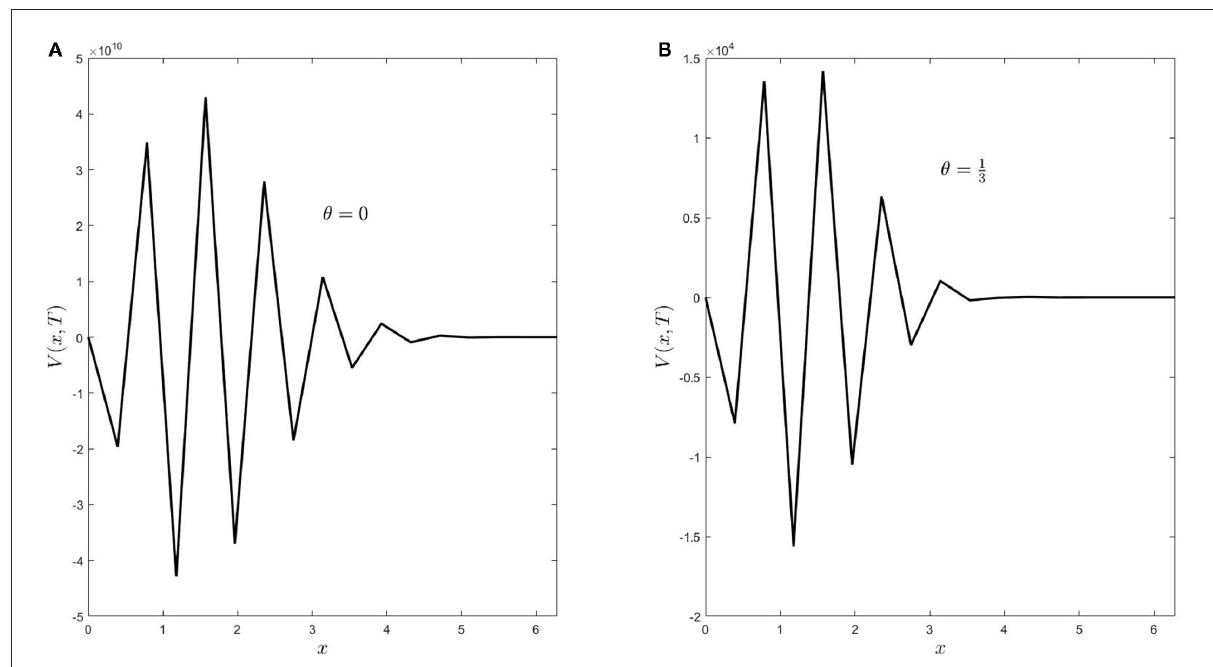
FIGURE5 (A,B) The plot of V ( x , τ